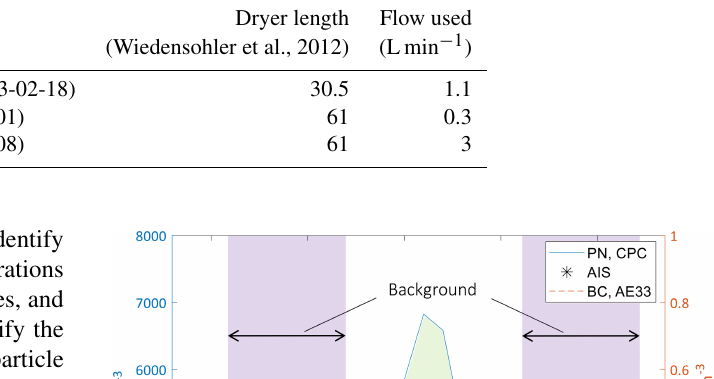
Table 1. Specifications of dryers used in Falsterbo; letters A–C correspond to the driers in Fig. 2. Dryer